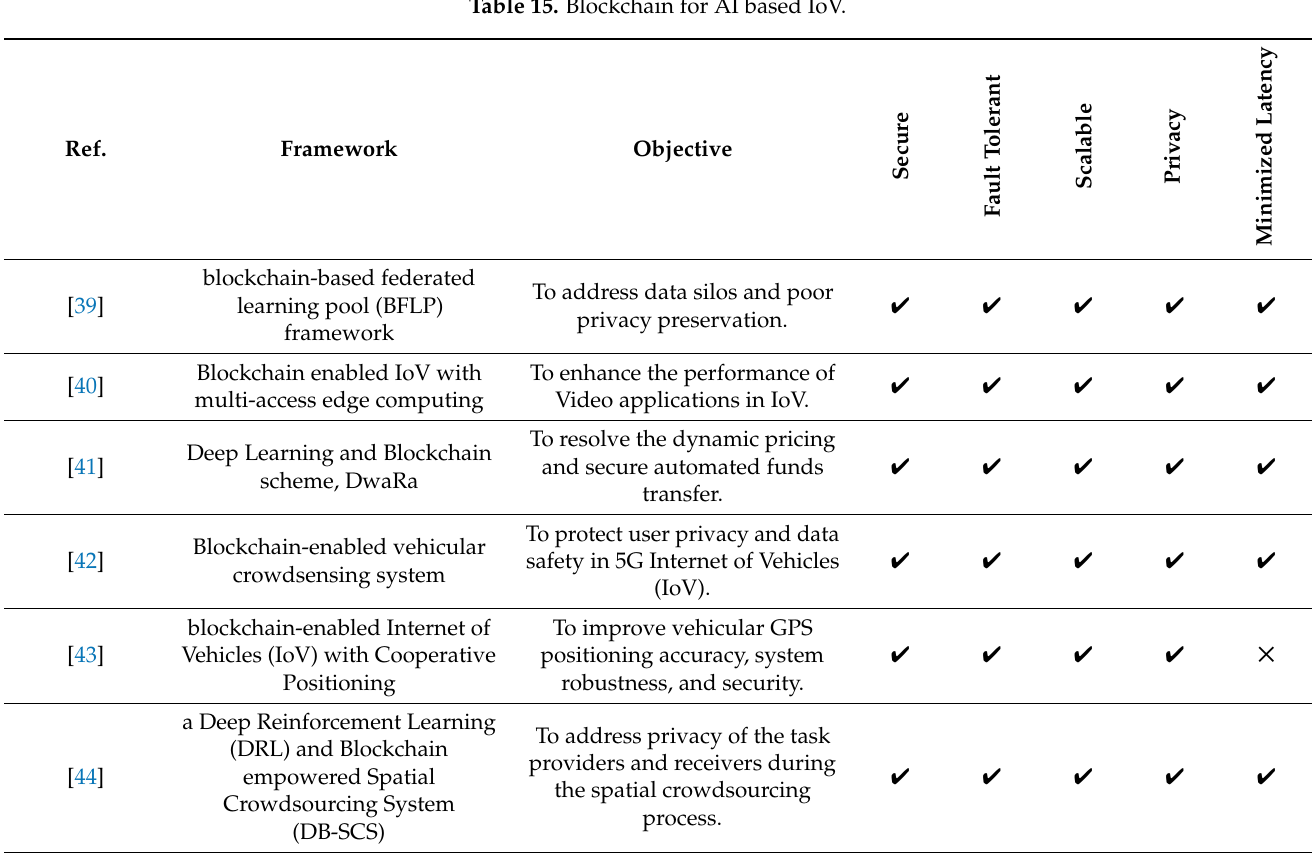
Table 15. Blockchain for AI based IoV.